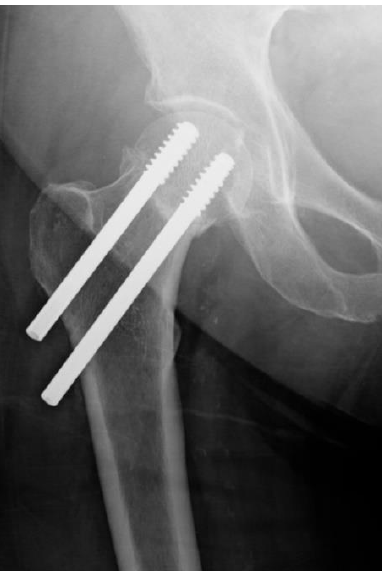
Figure 2. Undisplaced femoral neck fracture after cannulated screw fixation (CSFN) implantation in anteroposterior view.